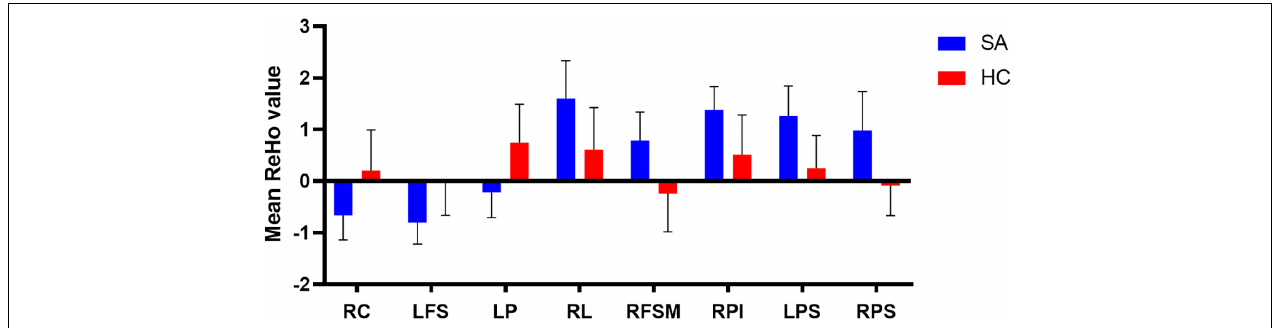
FIGURE 3 | The mean ReHo values in different brain regions in SA and HC groups. RC, right cerebellum; LFS, left frontal superior; LP, left putamen; RL, right lingual; RFSM, right frontal superior medial; RPI, right parietal inferior; LPS, left parietal superior; RPS, right parietal superior.